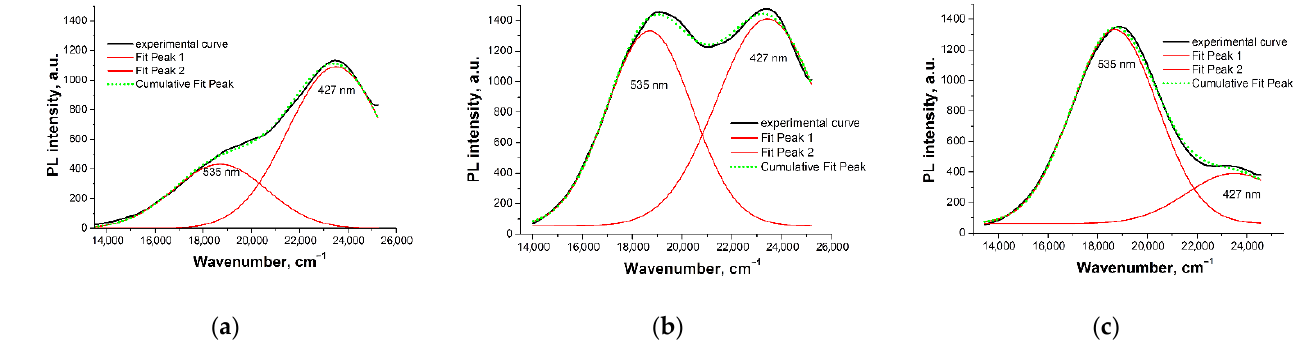
Figure 4. PL spectra of (H 3 BO 3 +8-Hq) solution in IPA after 30 min exposure at ( a ) 45 °C, ( b ) 50 °C, and ( c ) 60 °C (λ ext = 365 nm).